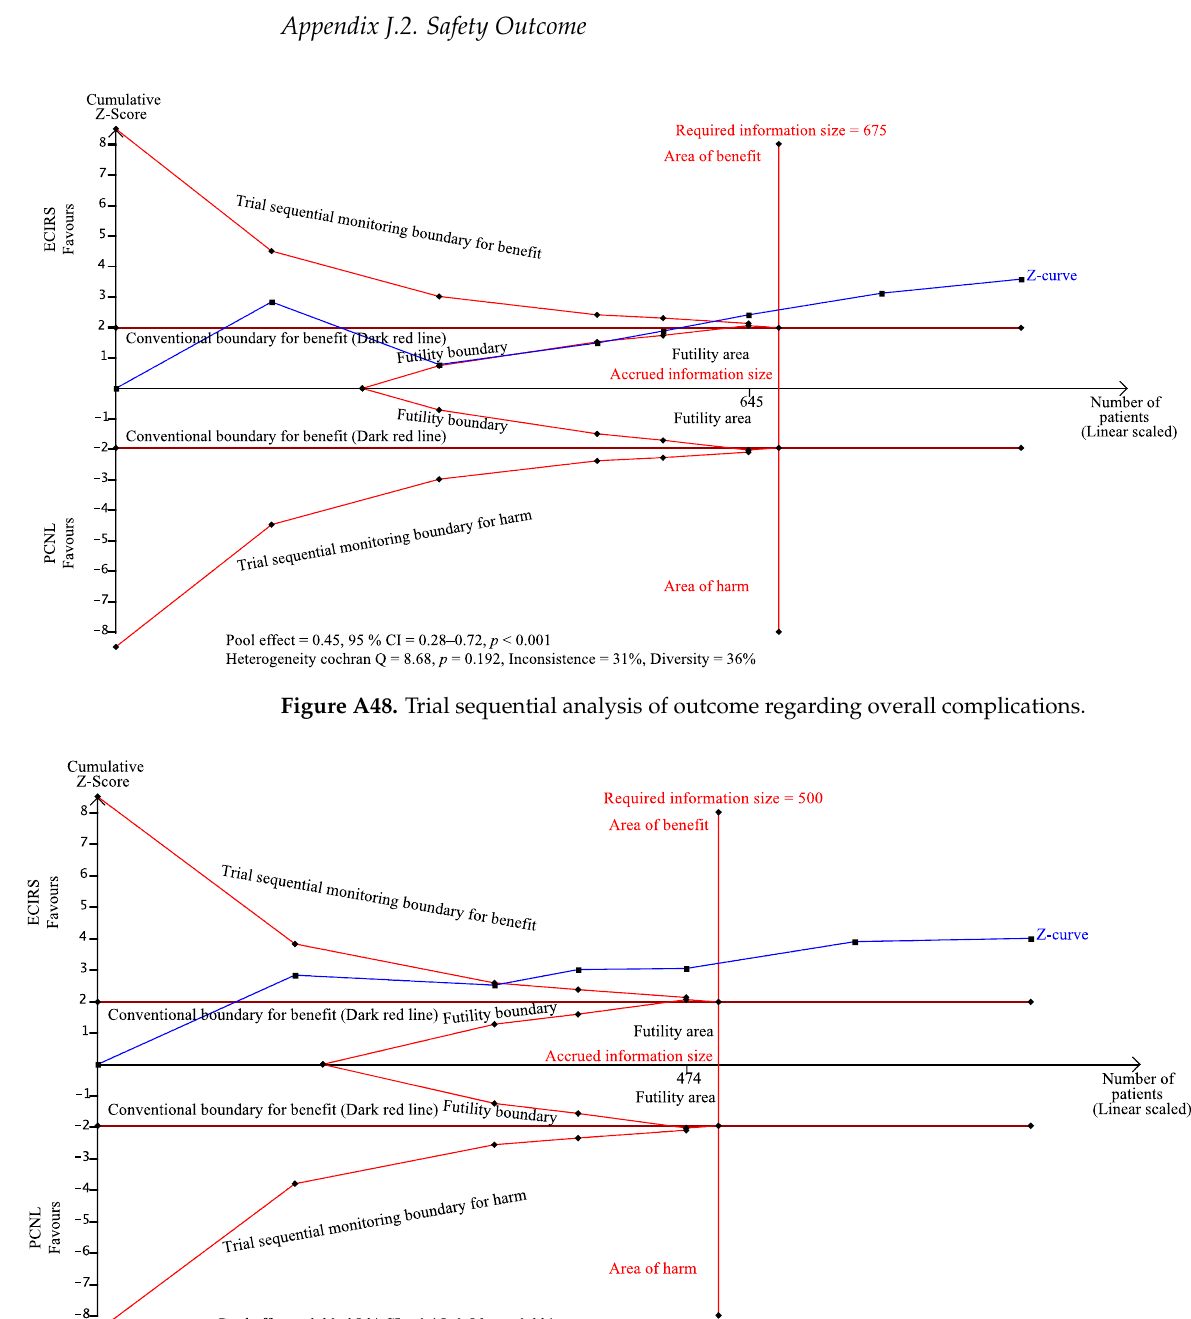
Figure A47. Trial sequential analysis of outcome regarding final stone free rate.